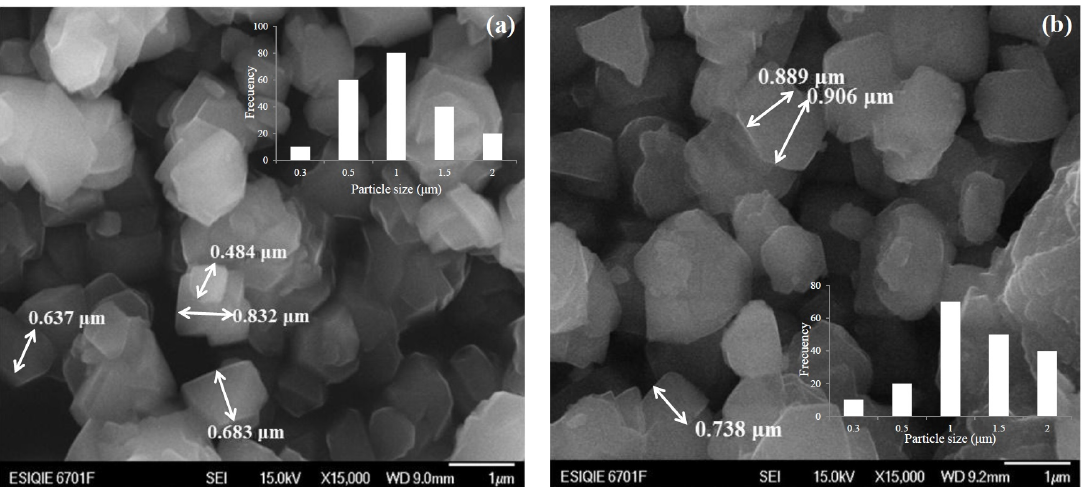
Figure 8. Scanning electron microscopy (SEM) images of ( a ) HY and ( b ) Pd/LaY zeolites.